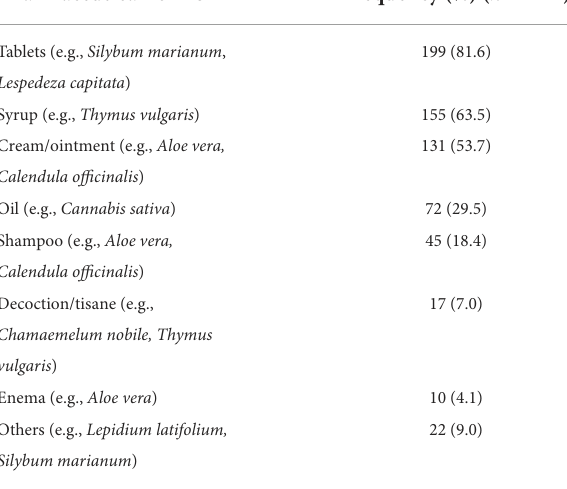
TABLE 7 Frequency of most common health problems treated, natural products and pharmaceutical forms used by the Spanish small animal veterinarians.